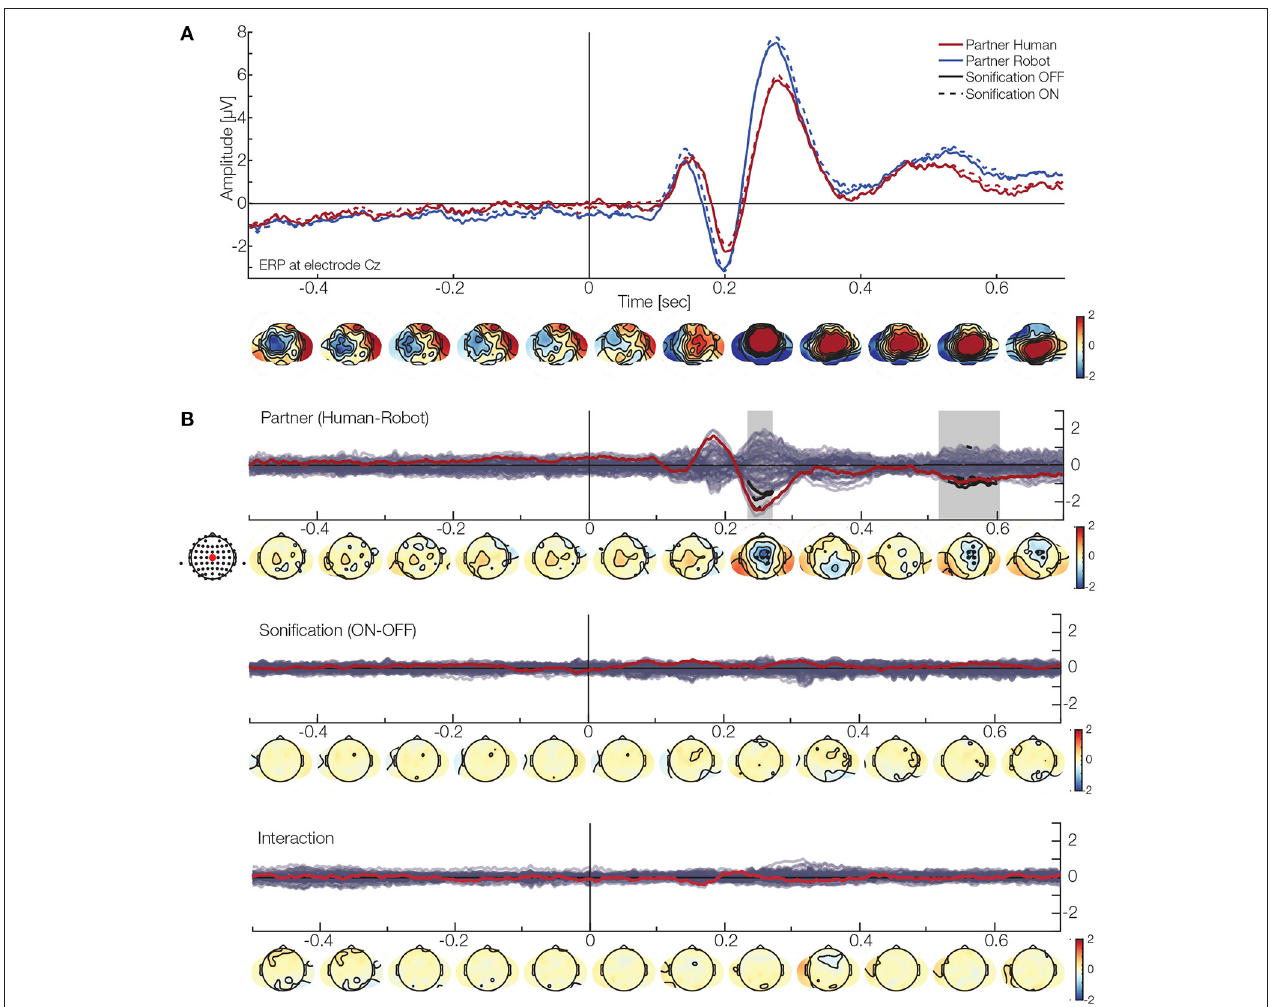
FIGURE 5 | EEG results. (A) ERP at electrode Cz. The red lines show the activation when interacting with a human partner, while blue lines indicate a robot partner. The solid line are the ERP when the sonification was off, while the dashed line represent sonification on. Below, are the topographies for the grand average (mean over all conditions). (B) Clustering results for the different factors (red line and dot represents electrode Cz). Top: Effect of partner. The analysis finds two clusters in the central area (black dots and segments). One is likely due to a difference at around 230–270 ms, while the second one is present later (around 510–600 ms). These results indicate that the ERP will have a smaller amplitude when interacting with a human partner. Middle: Effect of sonification. No cluster was found here. Bottom: Interaction. No cluster was found